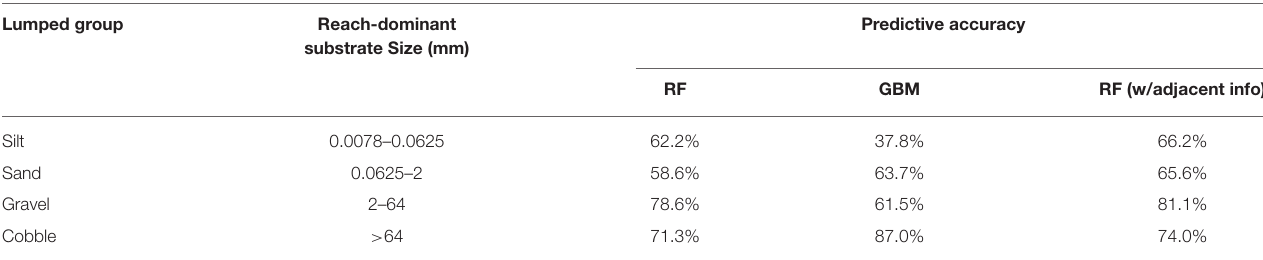
TABLE 2 | Predictive accuracy of lumped four groups with different model